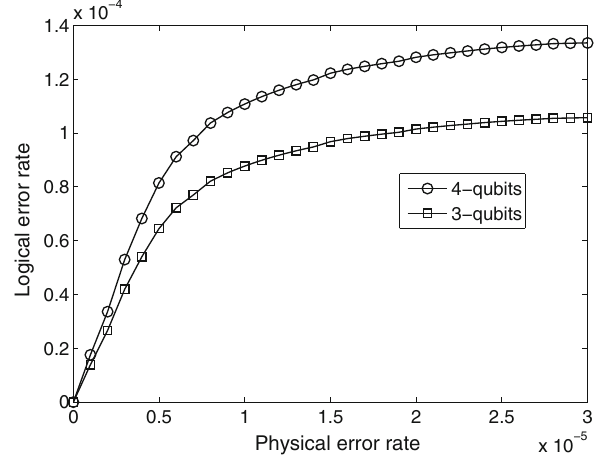
Fig. 2 Logical error rate vs. physical error rate for QEAC with Q